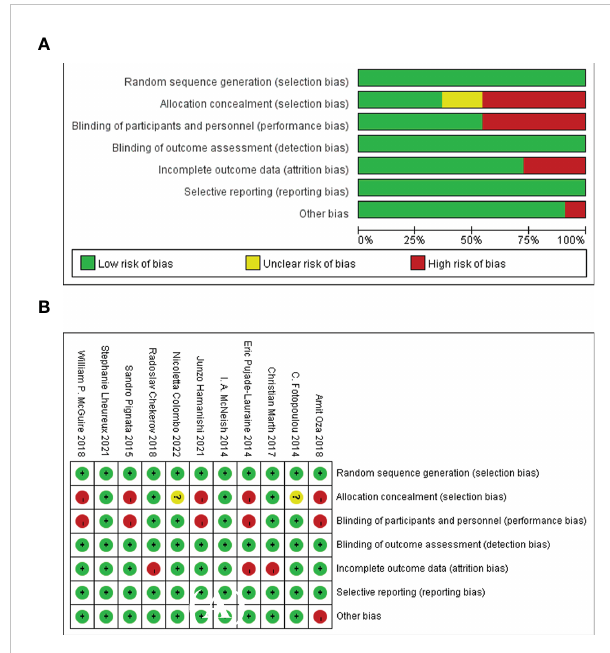
FIGURE 3 The assessment of risk of bias for the included studies. (A) Summary risk of bias, (B) Detailed risk of bias in each study.